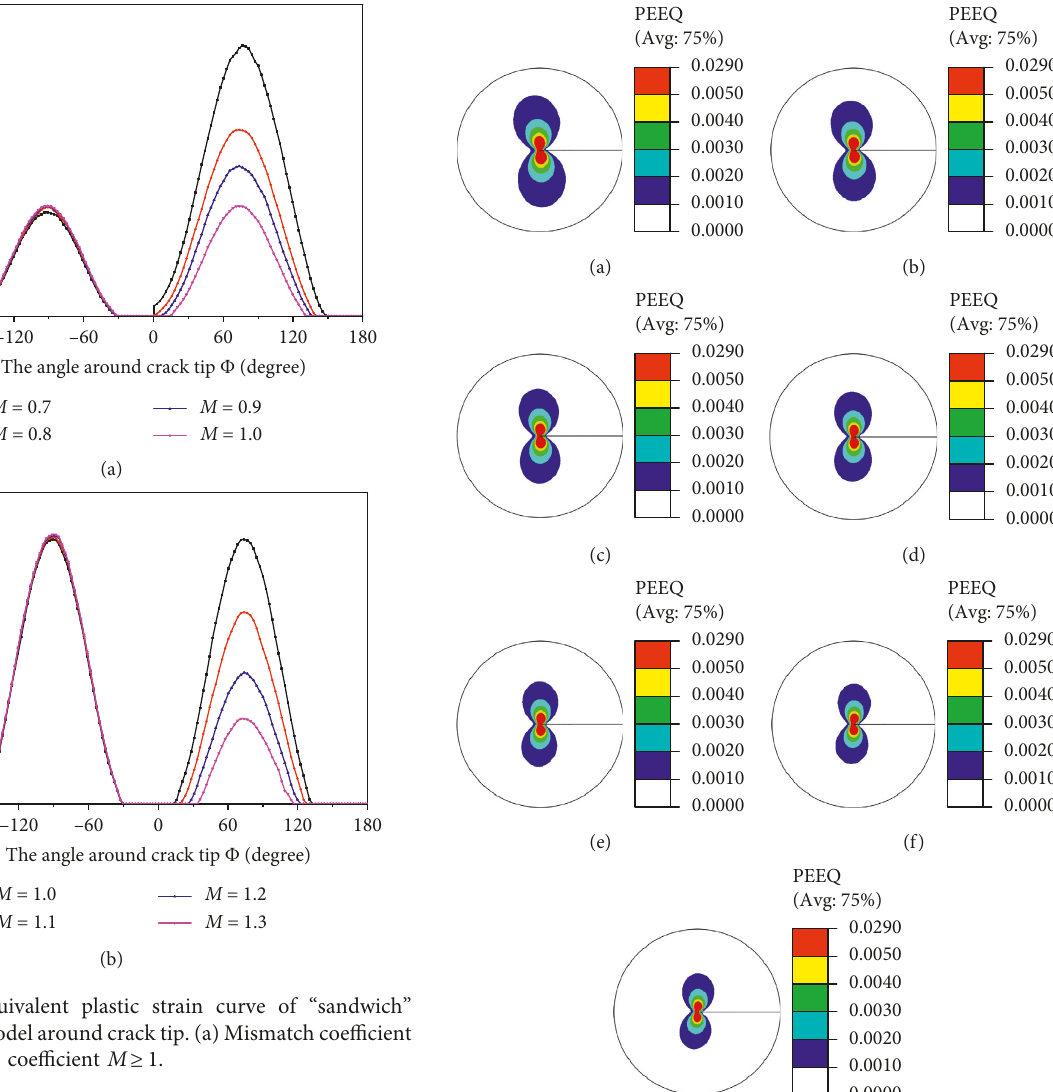
Figure 17: The equivalent plastic strain contour of continuous transition material model around crack tip. (a) M � 0.7. (b) M � 0.8. (c) M � 0.9. (d) M � 1.0. (e) M � 1.1. (f) M � 1.2. (g) M �